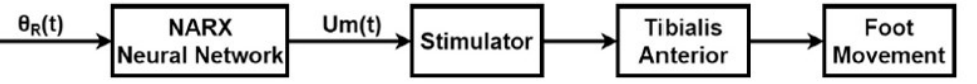
Figure 6. Open-loop dynamic inverse NARXNN control strategy. The NARXNN receives the desired foot angle trajectory θ R ( t ) and predicts the control command U m ( t ) , which is sent to the stimulator, delivering stimulation